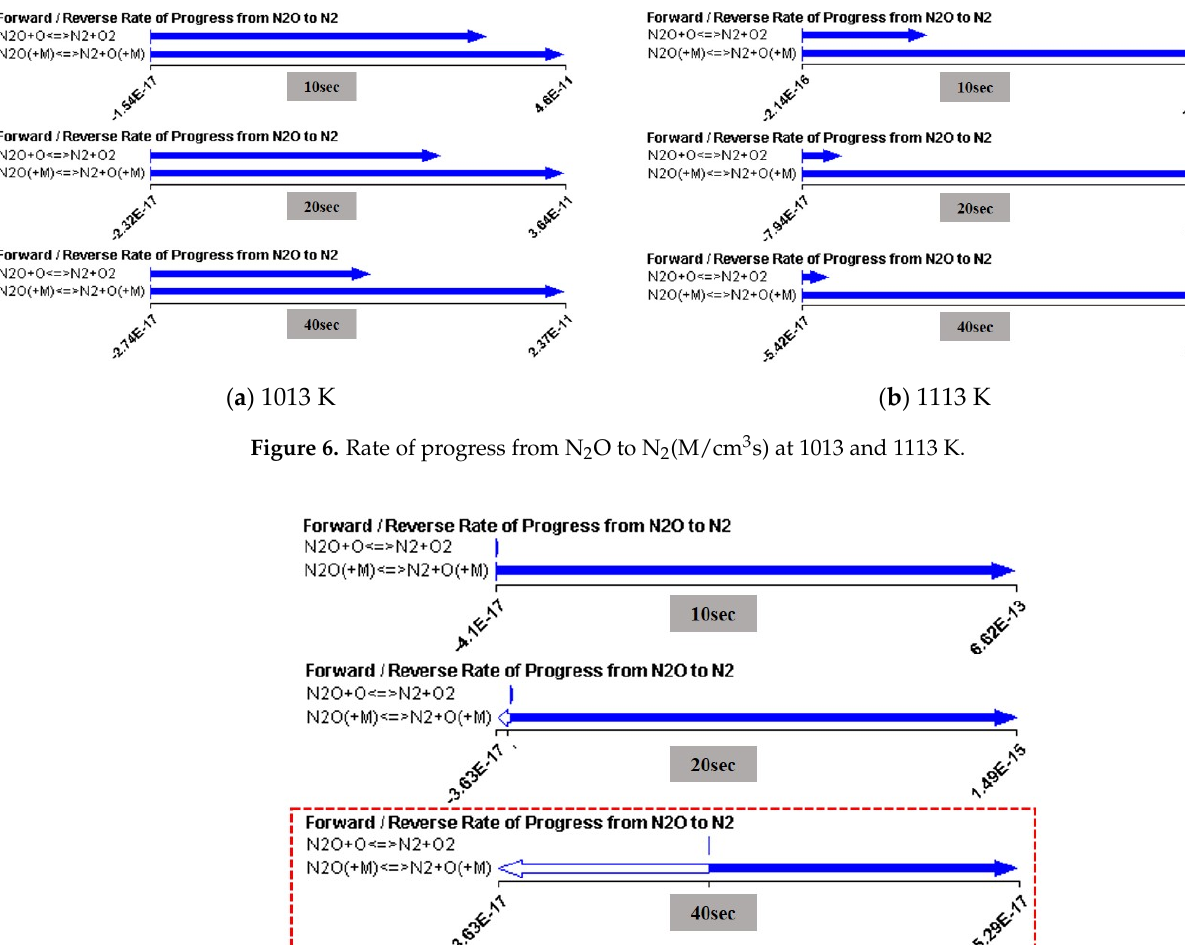
Figure 7. Rate of progress from N 2 O to N 2 (M/cm 3 s) at 1213 K. Table 5. Rate of progress between N 2 O and N 2.